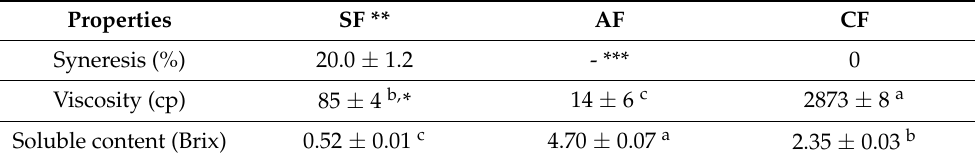
Table 4. Physical properties of vegetable dietary fibers.